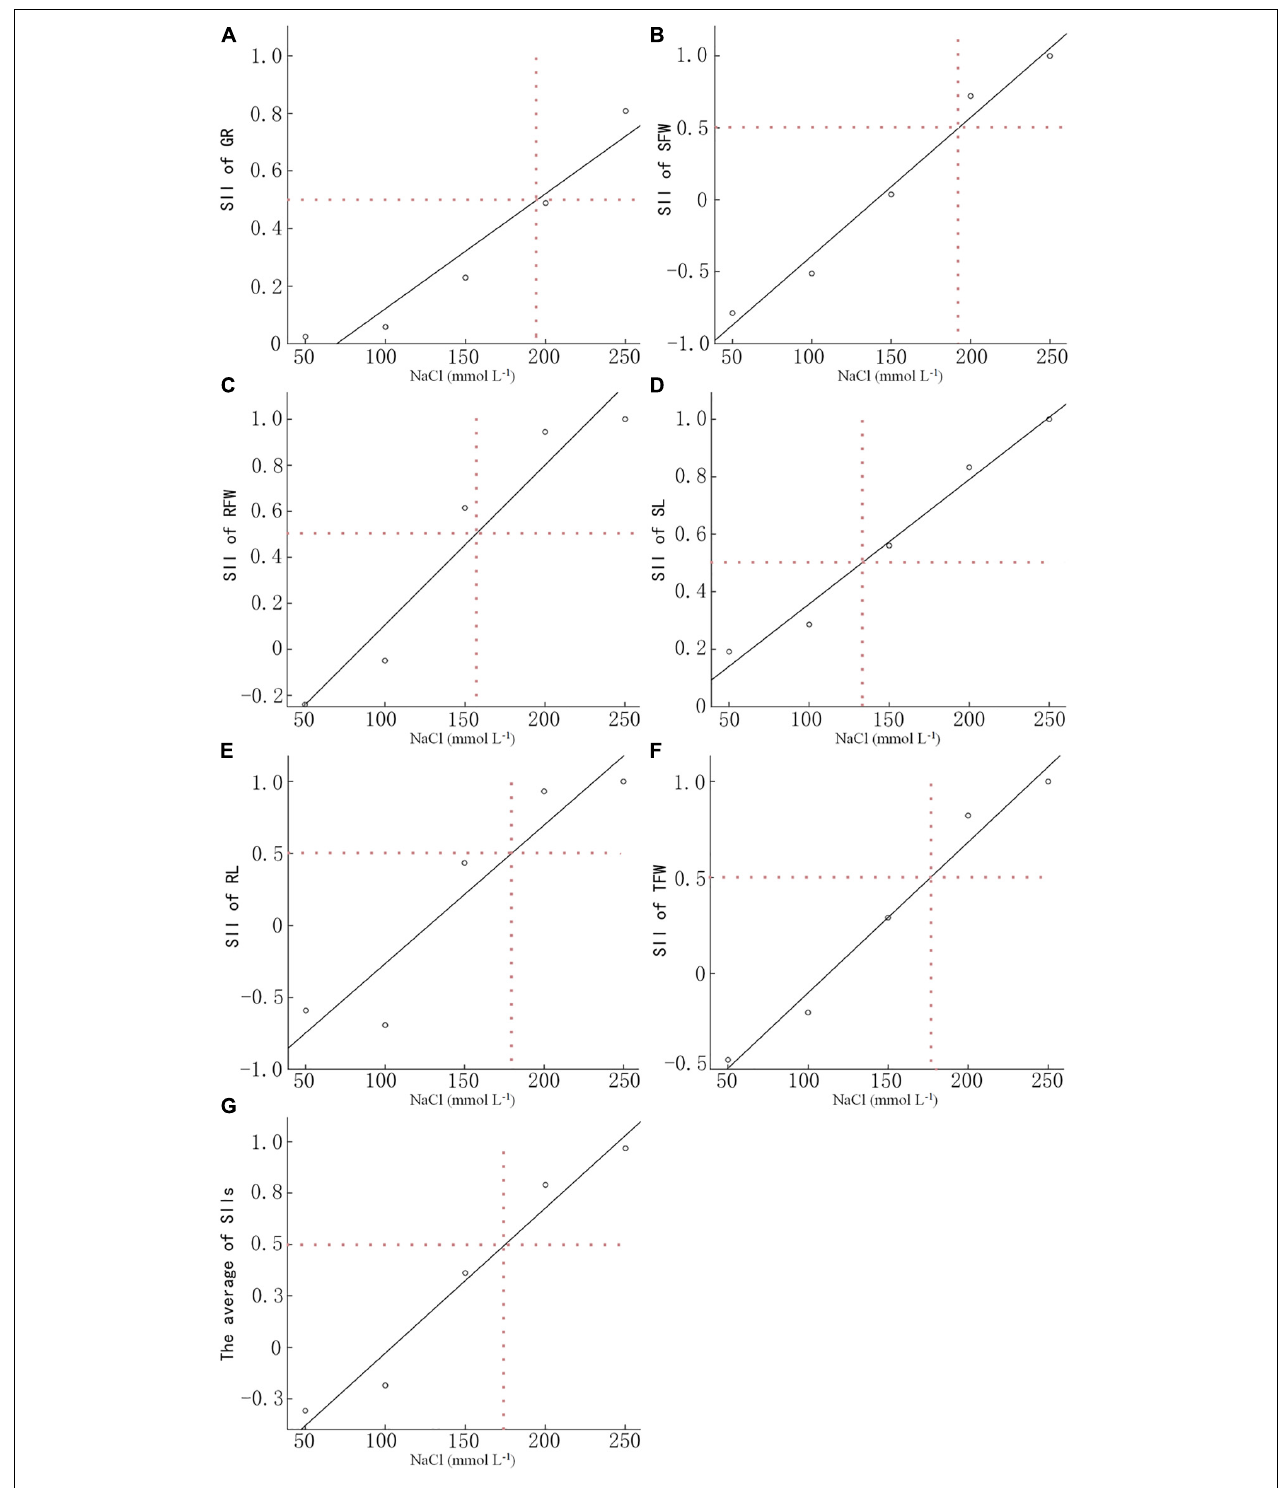
FIGURE 1 | Determination of the optimal NaCl concentration for evaluating salt tolerance. The NaCl concentration of the salt-injury index is 0.5 of the germination rate (A) , shoot fresh weight (B) , root fresh weight (C) , shoot length (D) , root length (E) , total fresh weight (F) , and the average (G) of 15 Brassica napus inbred lines under different NaCl concentrations. Data in the figure are means of 15 B. napus inbred lines for each indicator under each concentration of NaCl.